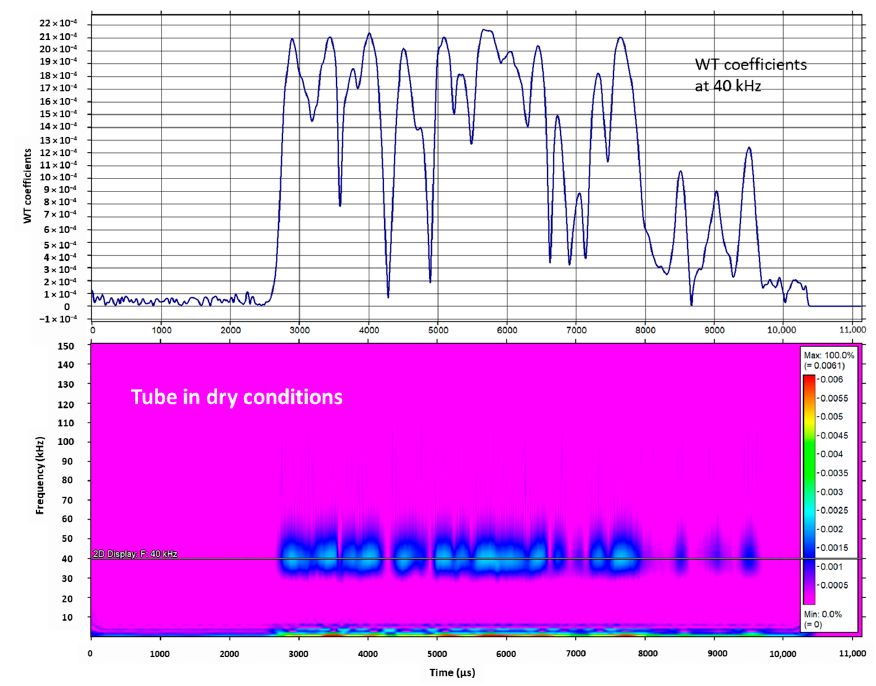
Figure 7. Experiment setup of a tube dry and flooded at 5% and 10% its height.